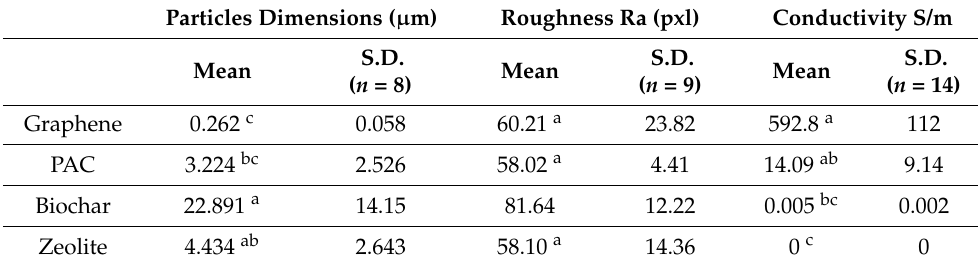
Table 1. Particle size and roughness (Ra) distribution based on the direct measurement on SEM images; data are expressed as mean and standard deviation. Kruskal–Wallis (significant if p < 0.05); post hoc Dunn: different letters in columns mean significant differences between